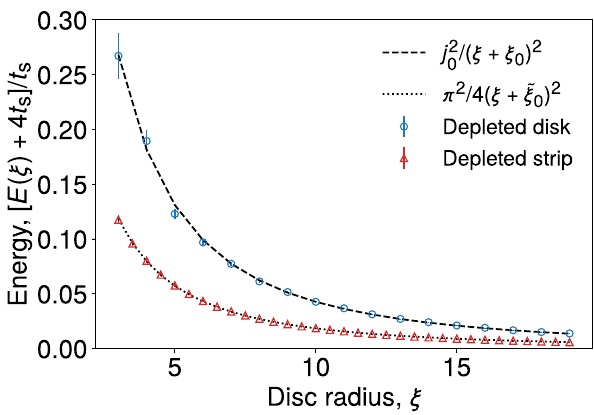
Fig. 5 Parameterising the spinon ground state energy. Average ground state energy of a spinon subjected to a vison distribution in which there exists an empty disc of radius ξ (blue circles), or the vison-depleted region forms a strip of width 2 ξ that wraps around the torus in one direction (red triangles), surrounded by a disordered region of π - fl uxes with average density 1/2. The dashed and dotted lines correspond to the best fi t to functions shown in the legend. The data are averaged over 250 fl ux realisations in a system of size L 2 = 40 2 , and the error bars denote the standard deviation of the energy at a given disc radius, not the error in the mean. The parametrisation chosen for E ( ξ ) on the vertical axis is merely a matter of parameter ξ 0 represents phenomenologically the penetration depth of the spinon wave function into the disordered vison background surrounding the empty circular patch. In order to fi x the value of ξ 0 , we sample random con fi gurations of visons in which there exists an empty disc of radius ξ , and in the complementary region the visons appear randomly with probability 1/2 per plaquette: